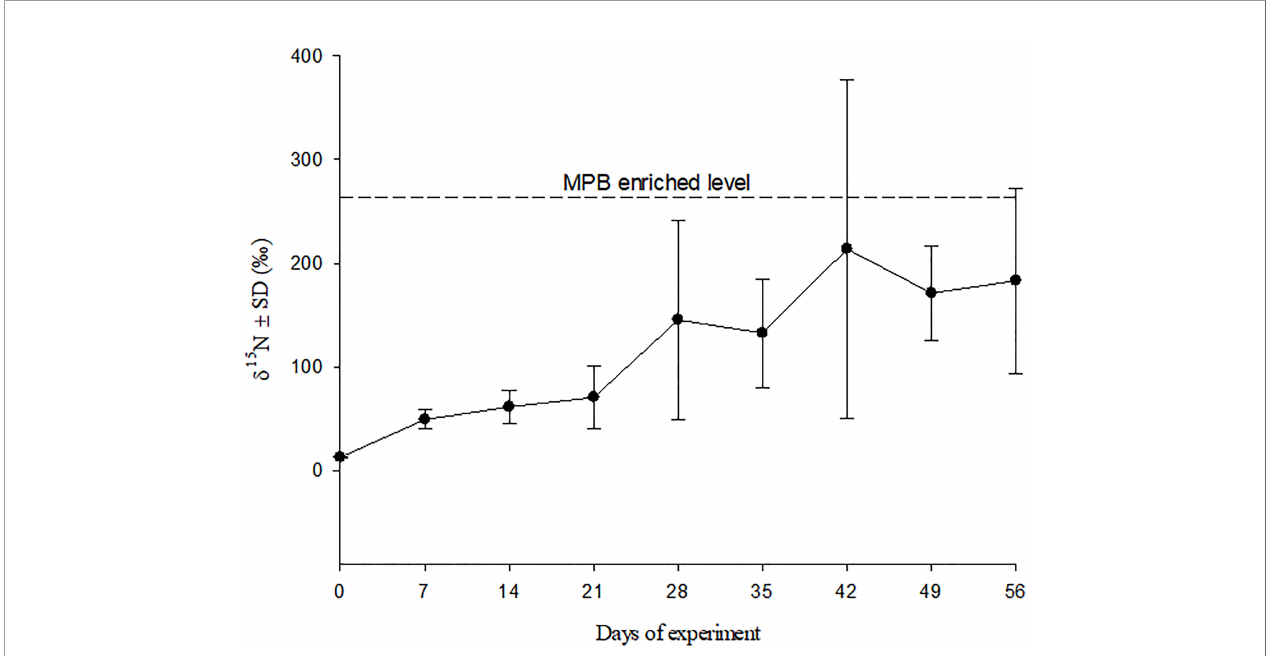
FIGURE 1 | d 15 N of muscle tissue of crabs fed 15 N-enriched MPB during the feeding experiment.